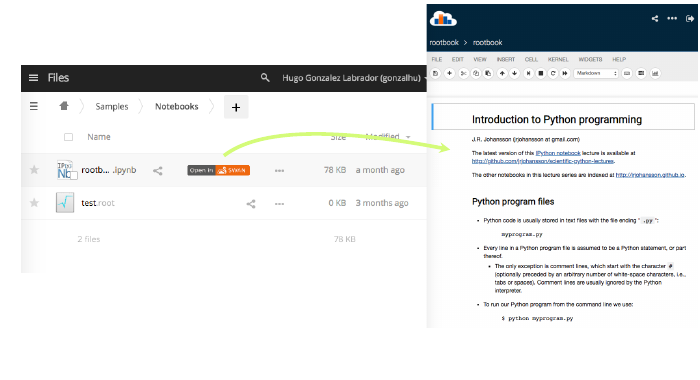
Figure 9. Integration of CERNBox with the SWAN